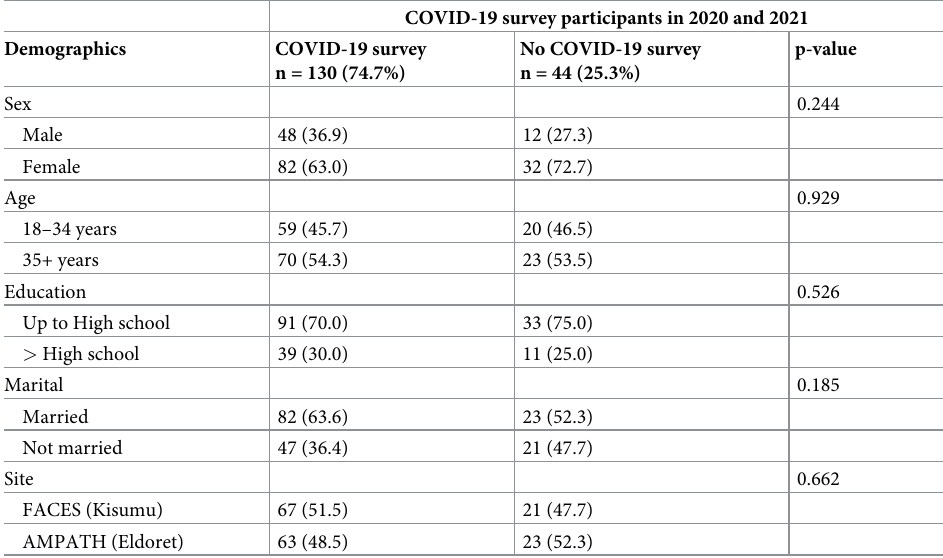
Table 1. Comparison of COVID-19 survey participants and nonparticipants, n =